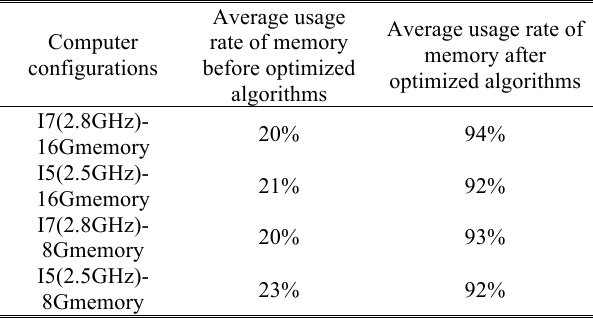
Table 2. Average usage rate of memory before and after optimized algorithms